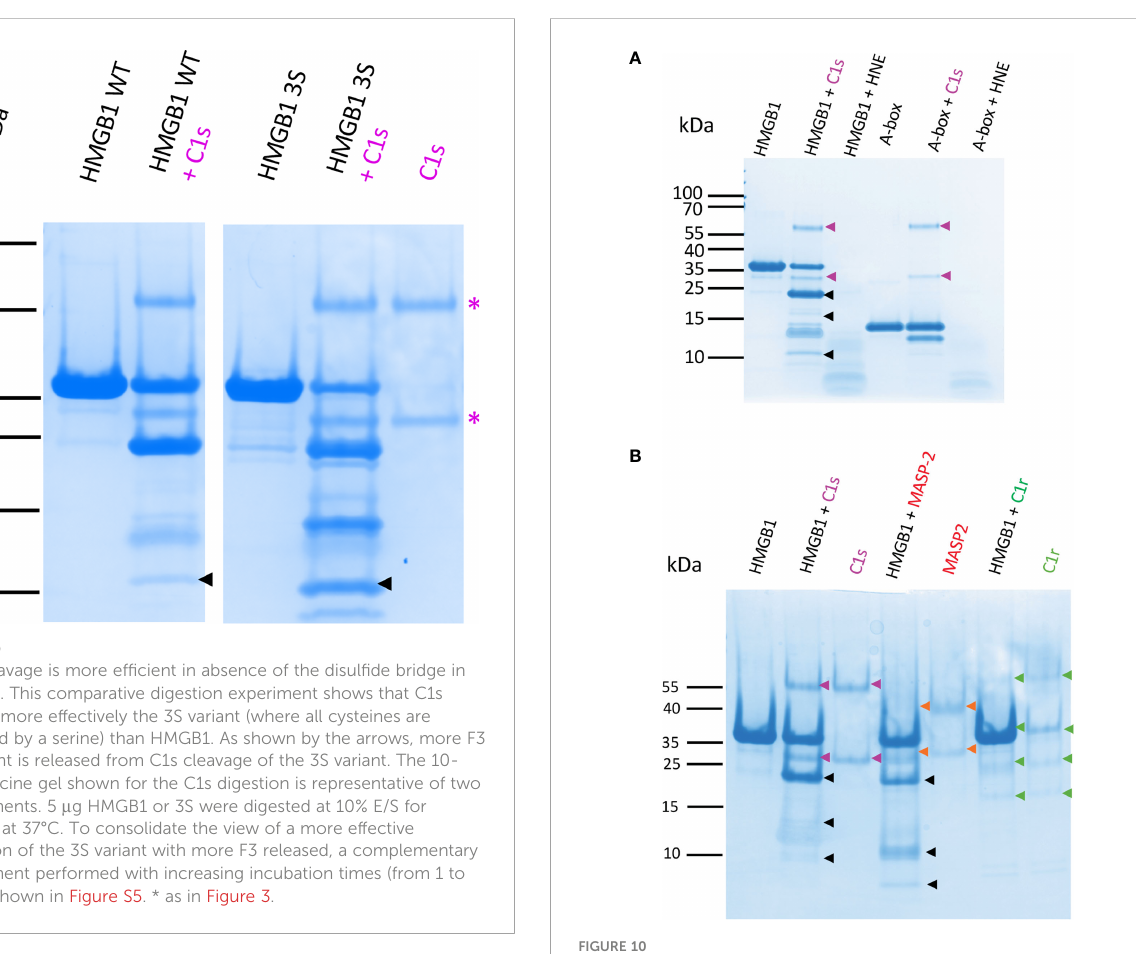
FIGURE 10 HMGB1 is mildly digested by C1s and MASP-2 whereas HNE degrades it rapidly into numerous small molecular weight peptides. (A) 10 - 20% Tricine gels loaded with HMGB1 or the A-box incubated with C1s or HNE for 90 min. HNE cleavage of HMGB1 yields many unde fi ned small molecular weight fragments and completely digests HMGB1. The A-box is not cleaved by C1s (as identi fi ed by LC/ESI MS, C1s only cleaves the tag off after 5 h, as seen in Figure 6B for rF3). In contrast, HNE rapidly degrades the A- box into small pieces. Gels were loaded with 0.1 nmol of HMGB1 (3 µg) or A-box (1.35 µg). HMGB1 and C1s or HNE were mixed at a 10% E/S molar ratio in TBS. A gel representative from two experiments is shown. HNE bands are not seen in these conditions, suggesting autolysis. (B) 10-20% Tricine gels loaded with HMGB1 incubated with C1s, MASP-2 or C1r for 90 min at 10% E/S. C1r does not cleave HMGB1. MASP-2 cleaves HMGB1 quite similarly as C1s, but the secondary cleavage products and proportions differ. A gel representative from two experiments is